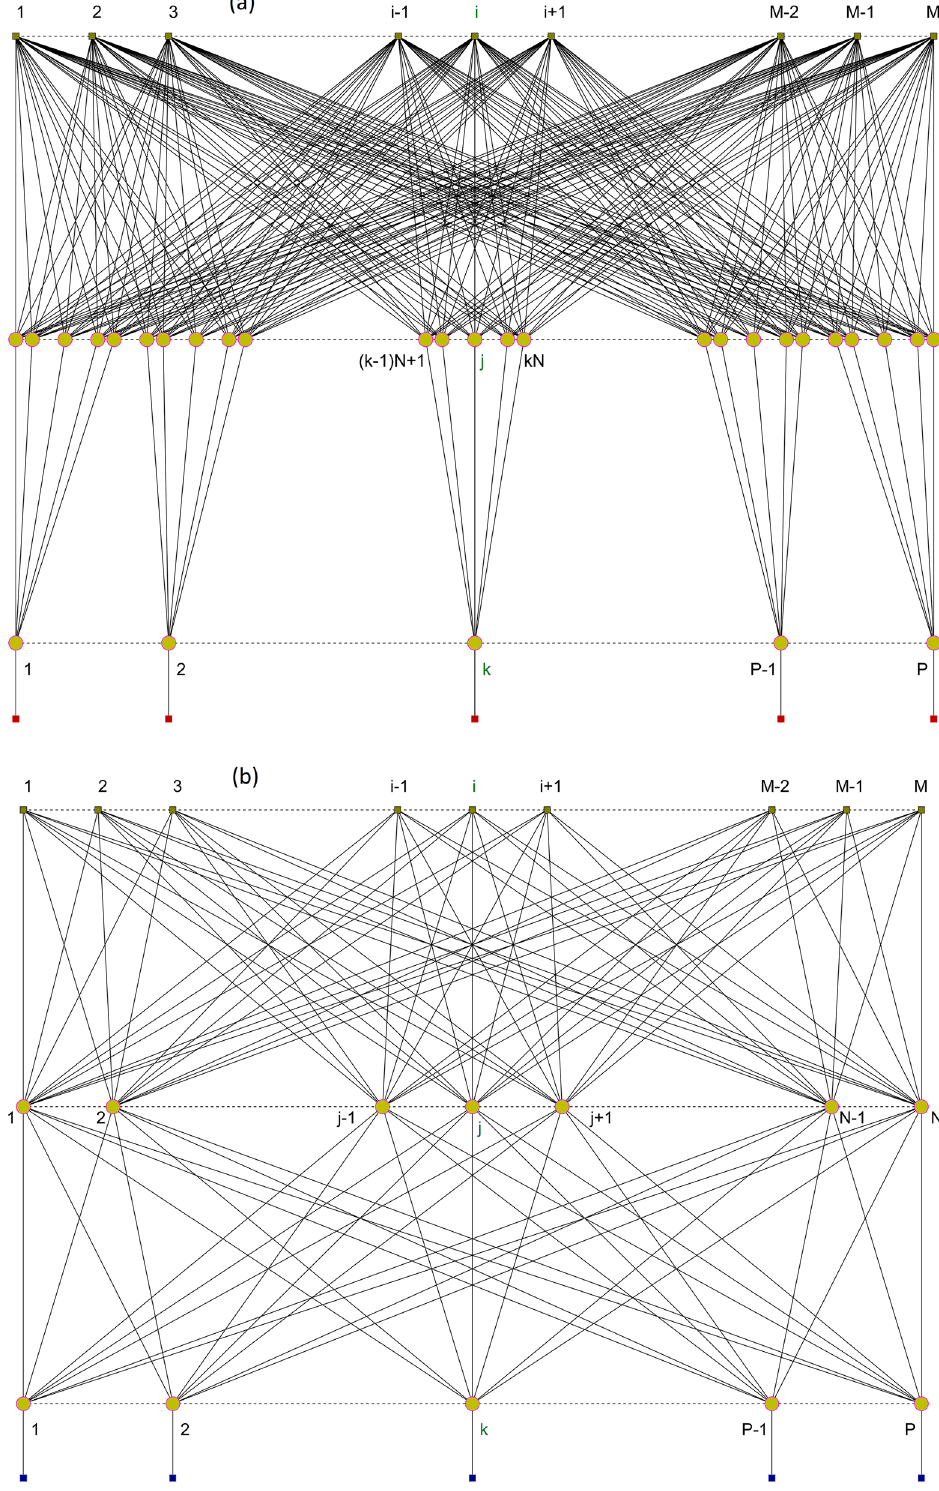
Figure 1. Connection diagram for: ( a ) NN composed of P independent subnets, each with different N nodes in the HL and the same M nodes in the IL; ( b ) NN with common architecture, having P nodes in the OL, N nodes in the HL, and M nodes in the